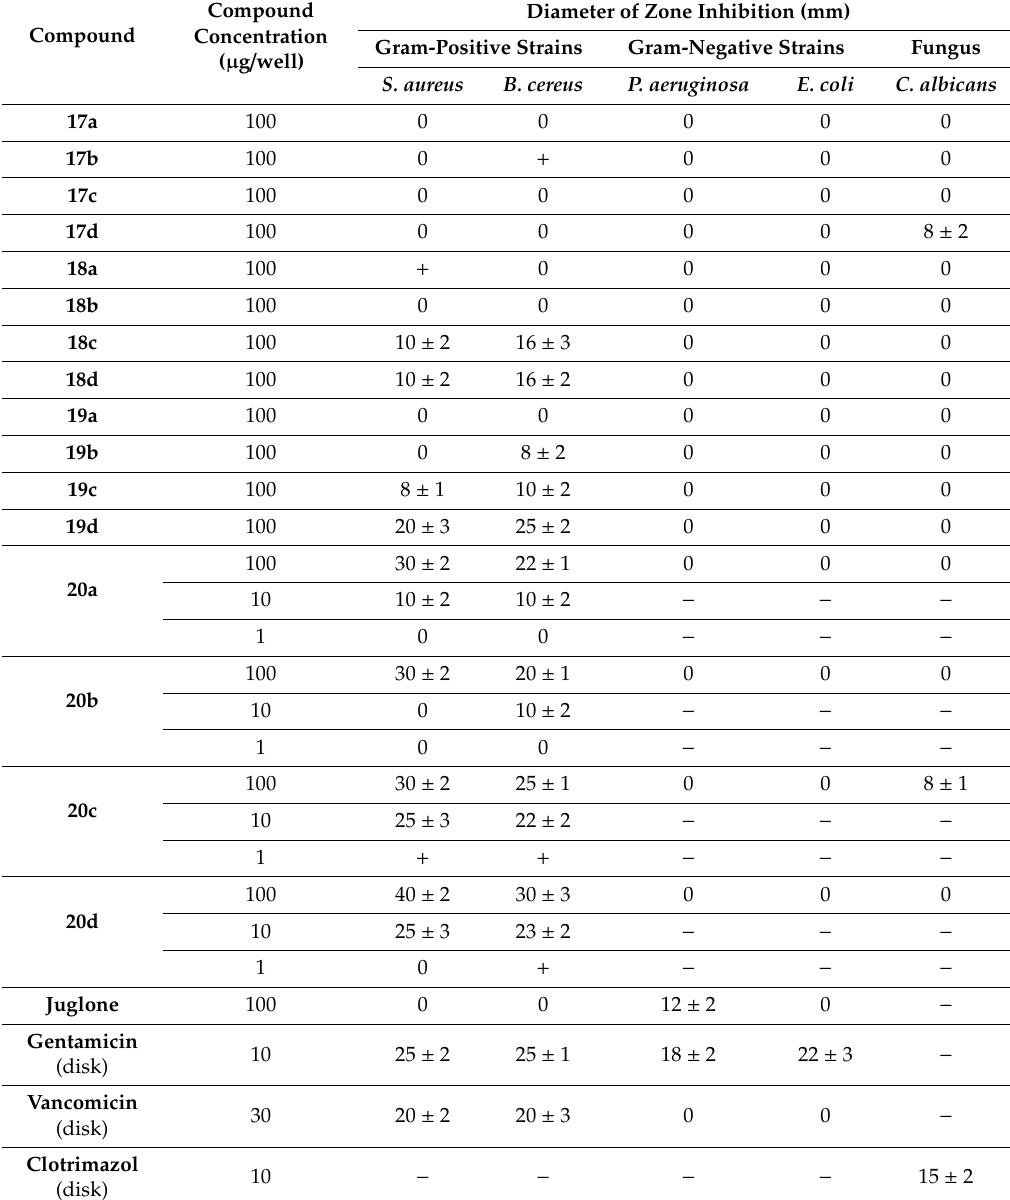
Table 3. Antimicrobial activity (zone inhibition) of oxathiine fused 1,4-naphthoquinone- thioglucoside